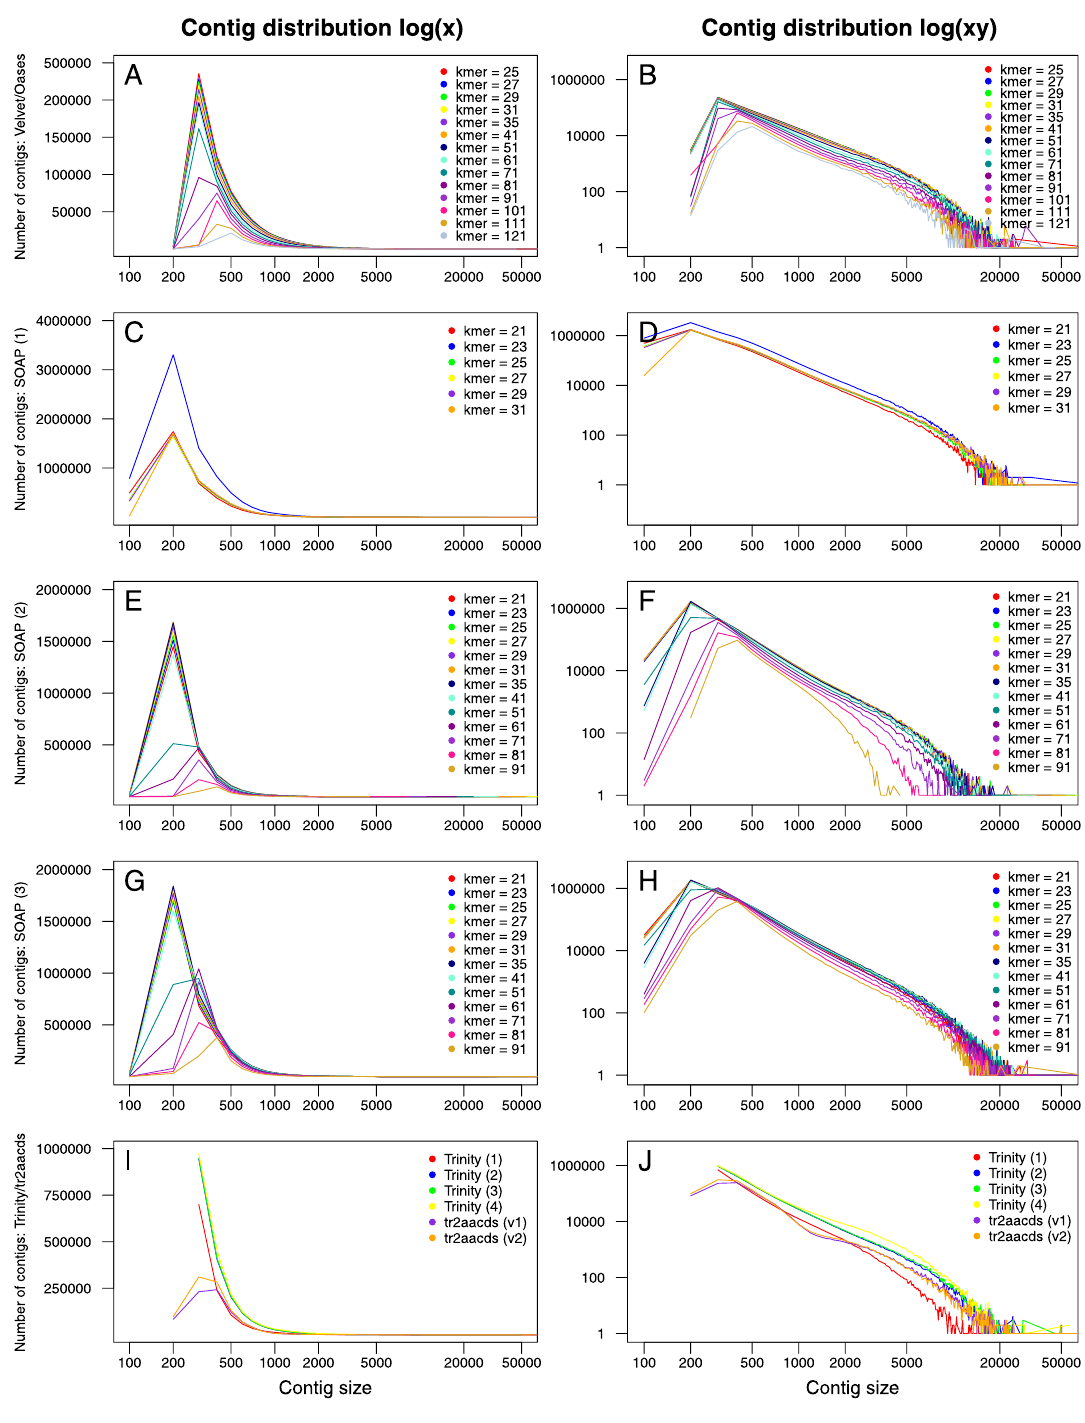
Figure 7. Distribution of contig number and size for all assemblies. Velvet/Oases: moderate filtering of poor quality read pairs; SOAPdenovo-Trans (1): no filtering; (2): light filtering of poor quality read pairs, combined with in silico normalization; (3): moderate filtering of poor quality read pairs; Trinity (1): light filtering of poor quality read pairs, combined with in silico normalization; (2): moderate filtering of poor quality read pairs; (3): light filtering of poor quality read pairs, combined with SEECER error correction; (4) Trinity v2.3.2 after moderate filtering of poor quality read pairs; tr2aacds merged assemblies (v1): pre-v2.3.2 Trinity; (v2) including v2.3.2 Trinity